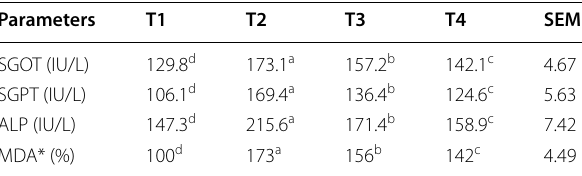
Table 4 The results of liver enzymes analysis and lipid peroxidation in the liver tissue